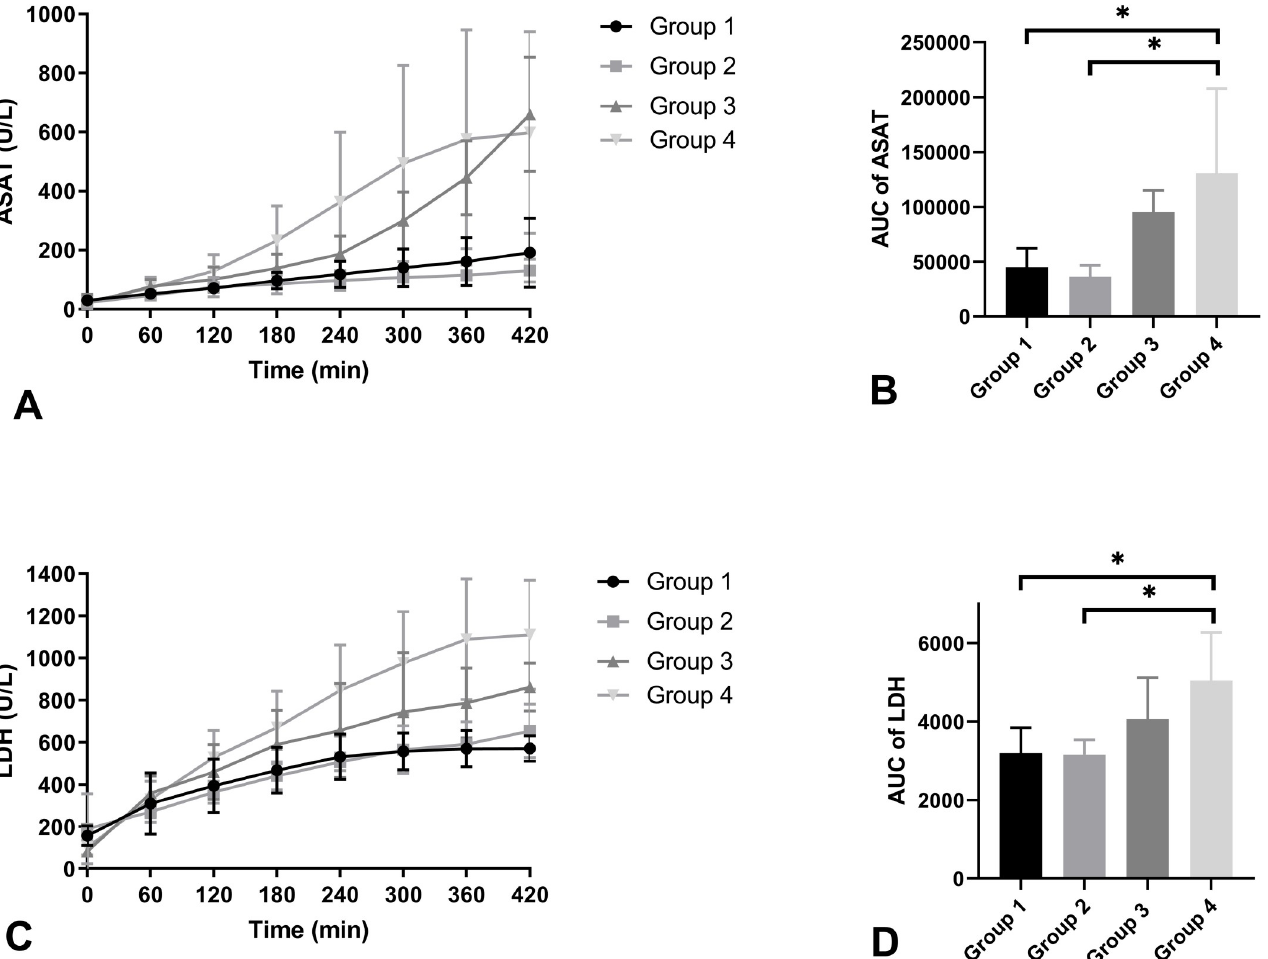
Fig 7. ASAT levels (U/l) (A), AUC of ASAT (B), LDH levels (U/l) (C), and AUC of LDH (D) of the four experimental groups during NMP (mean + SD). � indicates a level of significance of p � 0.05.